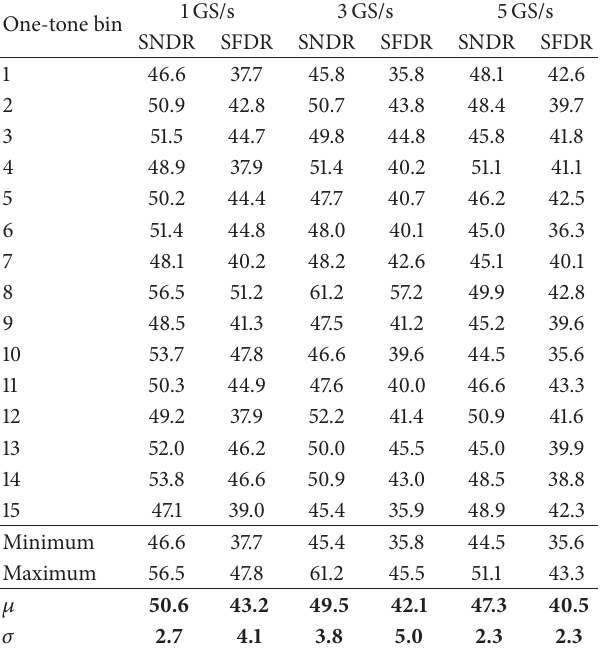
Table 2: Table of SNDR and SFDR with 1-tone, on-bin, 0 dBFS